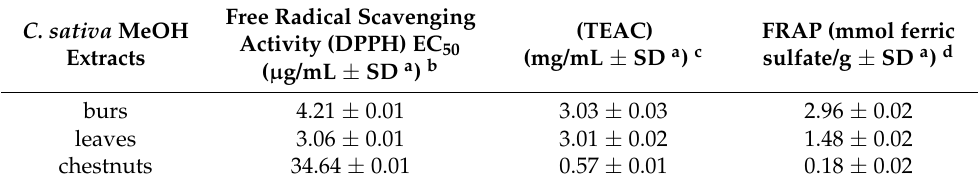
Table 2. Antioxidant activity of MeOH extracts of C. sativa (Marrone di Roccadaspide) burs, leaves, and chestnuts evaluated by Trolox Equivalent Antioxidant Capacity (TEAC), 1,1-diphenyl-2- picrylhydrazyl (DPPH), and Ferric Reducing Antioxidant Power (FRAP)